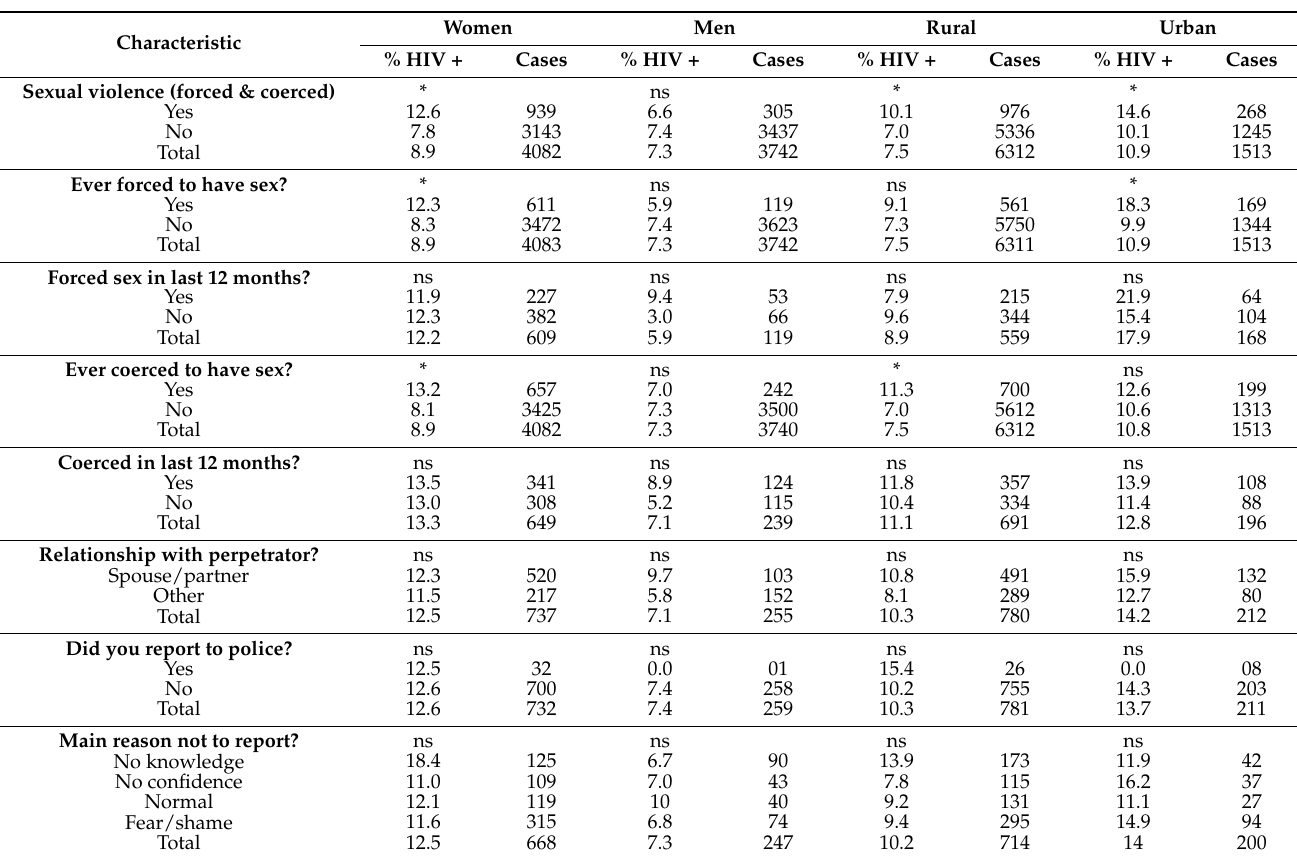
Table 2. HIV prevalence by forms of sexual violence, UAIS, 2011 ( n = 7784).